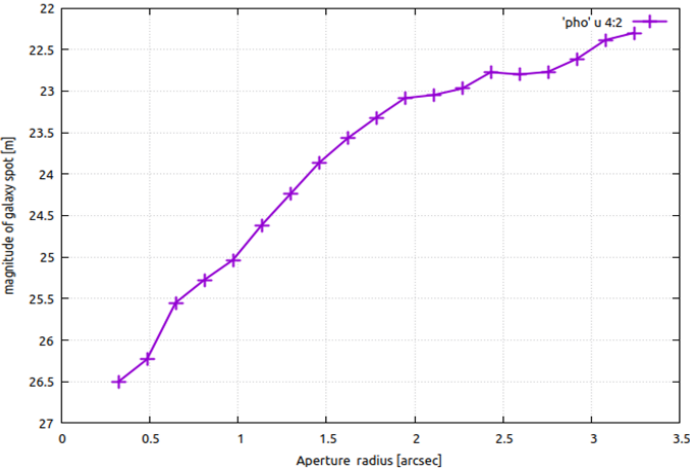
Figure 8. The brightness of the extended glow of the host galaxy (Table S2).